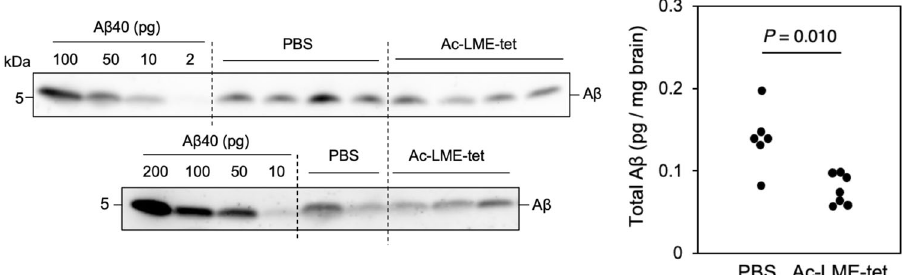
Fig. 6 Ac-LME-tet reduces A β levels in the brain of AD model mice. App NL-G-F/NL-G-F mice were intraperitoneally administered N-terminal-acetylated LME-tet (Ac-LME-tet) or phosphate-buffered saline (PBS) control. After 7 days, mice were then sacri fi ced, and the amounts of human A β present in the cerebral cortex and the olfactory bulb were measured by western blot using anti-human A β antibody 4G8. The indicated amounts of A β were used for quanti fi cation; n = 6 for control, and n = 7 for Ac-LME-tet-treated mice. Signi fi cance was determined by the Mann – Whitney U test; P = 0.010 for Ac-LME- tet-treated vs . PBS-treated